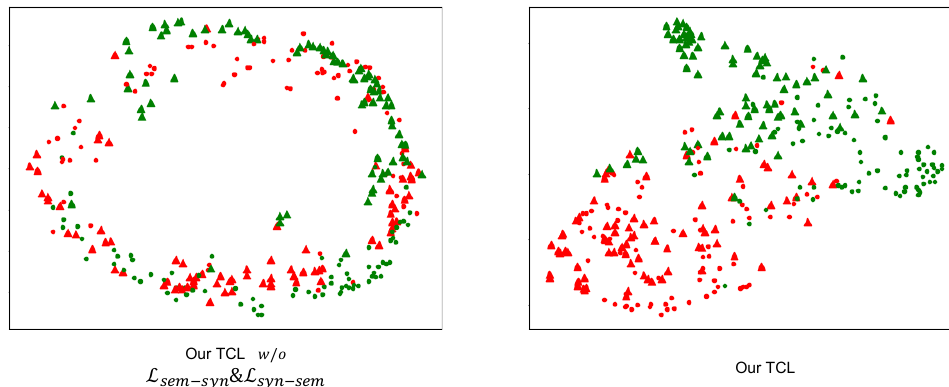
Figure 6. Visualization of semantic and syntactic vectors. Triangle dots represent syntactic vectors; round dots represent semantic vectors; dots in red represent positive samples; dots in green represent negative samples.